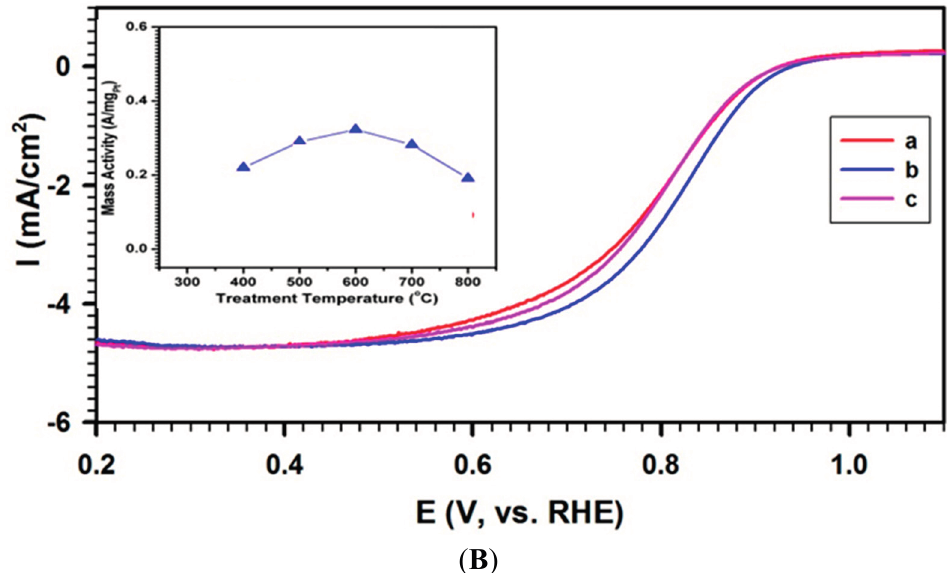
Figure 3. RDE curves for ORR for Au 22 Pt 78 /C ( A ) and Au 49 Pt 51 /C ( B ) catalysts treated under H 2 for 30 min (normalized for comparison) at 400 ( a ), 600 ( b ), and 800 °C ( c ). (Glassy carbon electrode (0.196 cm 2 ); 0.5 M H 2 SO 4 saturated with O 2 ; catalyst loading: 10 μ g; scan rate: 10 mV/s; speed: 1600 rpm). (reproduced from reference [27] with permission. Copyright 2010, American Chemical